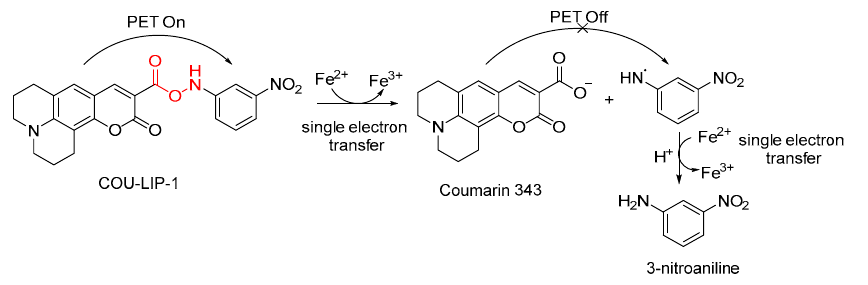
Figure 5. The fluorescence turn − on response mechanism of COU − LIP − 1 to Fe 2+ [45].